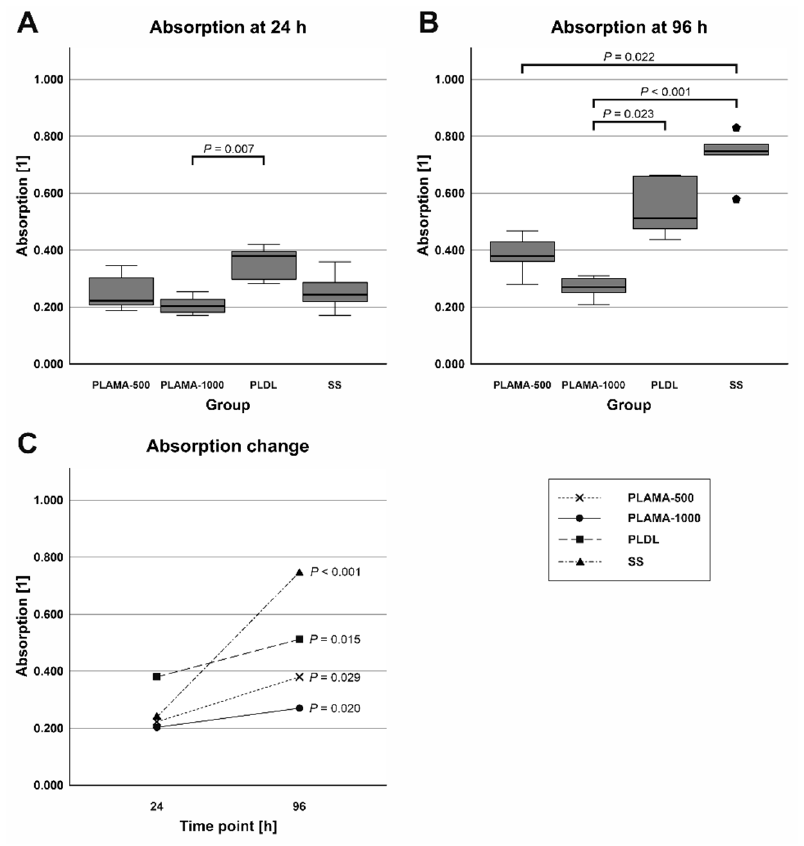
Figure 20. Absorbance at 450 nm measured at 24 ( A ) and 96 h ( B ) after seeding; the change in absorbance between the two time points ( C ).